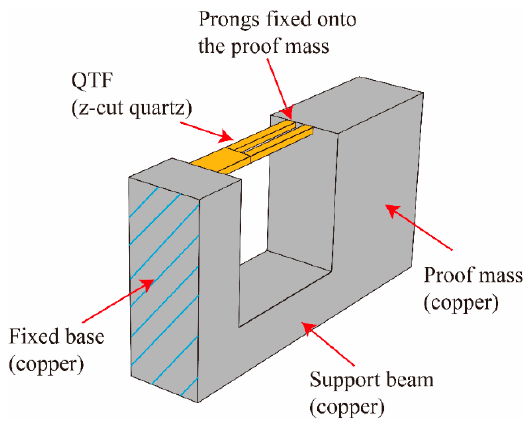
Figure 2. Schematic diagram of the DETF-based resonant accelerator.